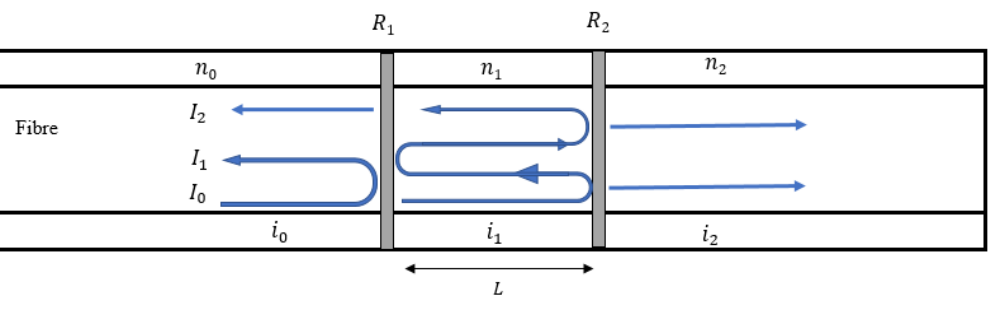
Figure 7. Light route in an FP (Fabry-Perot) cavity.